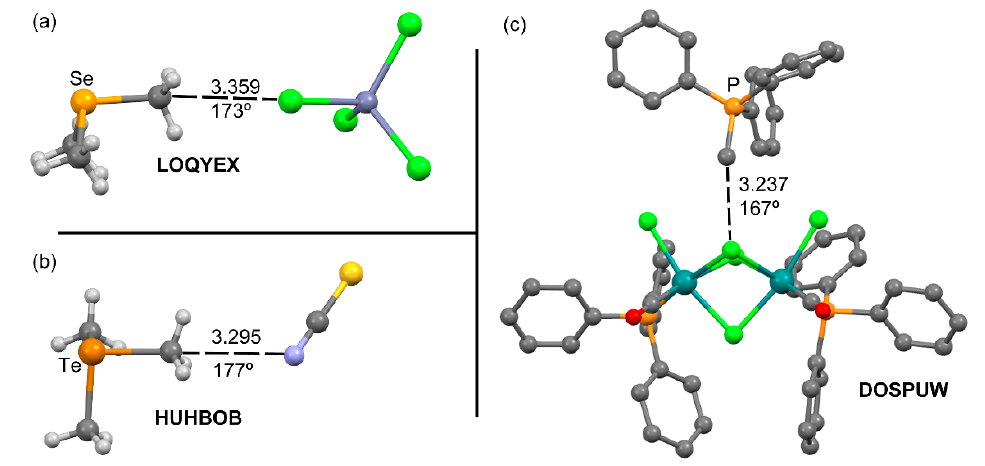
Figure 10. X-ray structures of CSD refcodes. ( a ) LOQYEX; ( b ) HUHBOB; ( c ) DOSPUW. Distances in Å are given adjacent to the dashed lines used to represent the TtBs.